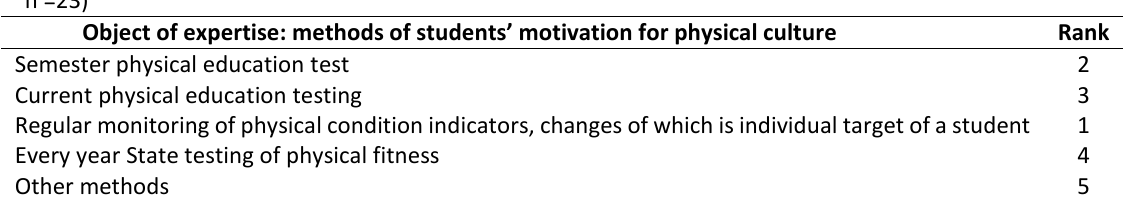
Table 3. Results of experts’ questioning about methods of students’ motivation for physical culture (W=0,738, n